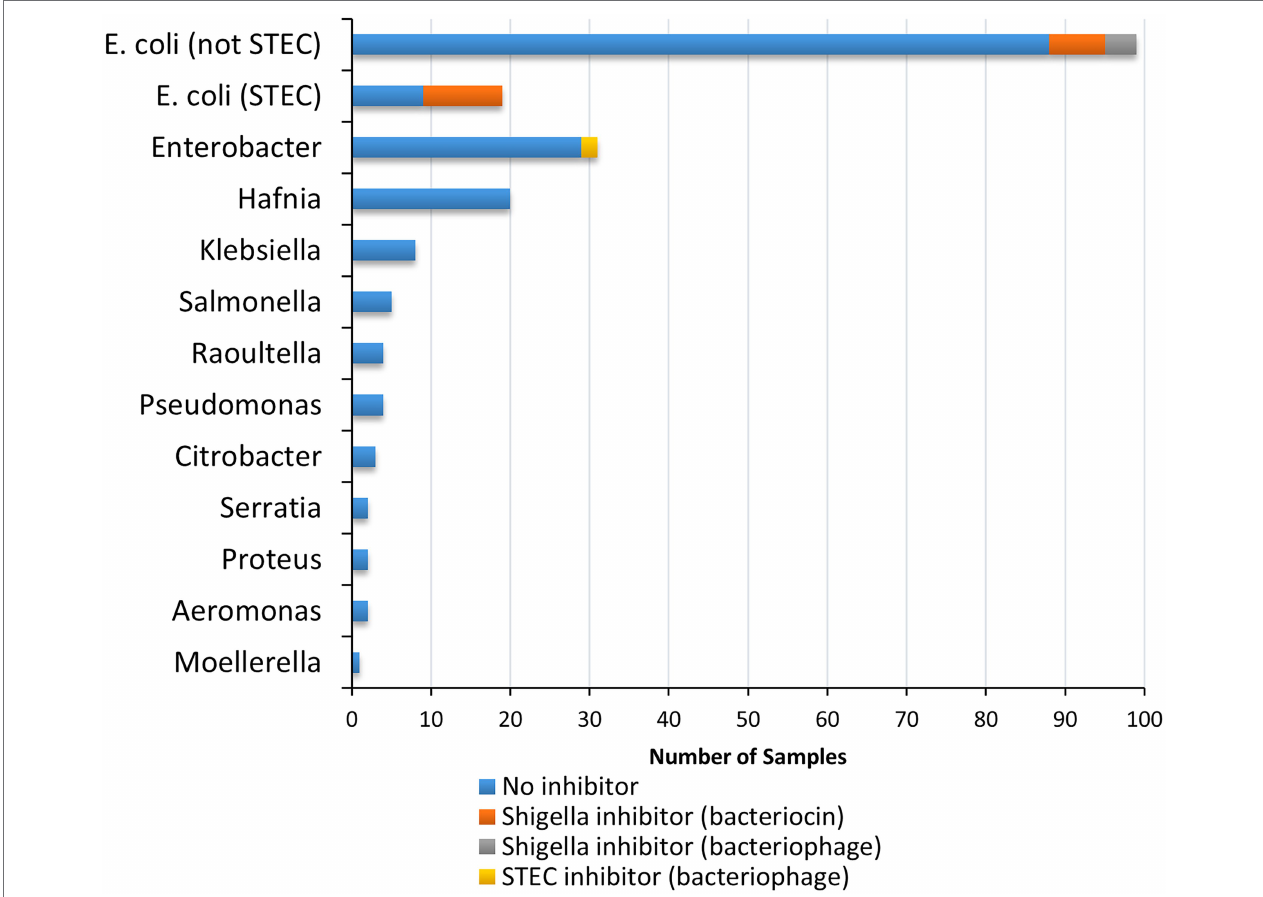
FIGURE 2 | Species and inhibitory activity of foodborne bacterial strains tested against Shigella and STEC. In total cell-free extracts from 200 bacterial strains were tested on five Shigella spp. strains (two Shigella sonnei , two Shigella flexneri, and one Shigella dysenteriae ) and seven STEC (Serotypes O26, O45, O103, O111, O121, O145, and O157) samples. Relative proportion of strains producing inhibitors are indicated according to genus impacted ( Shigella spp. vs. STEC), and predicted inhibitor (bacteriocin vs. bacteriophage; see